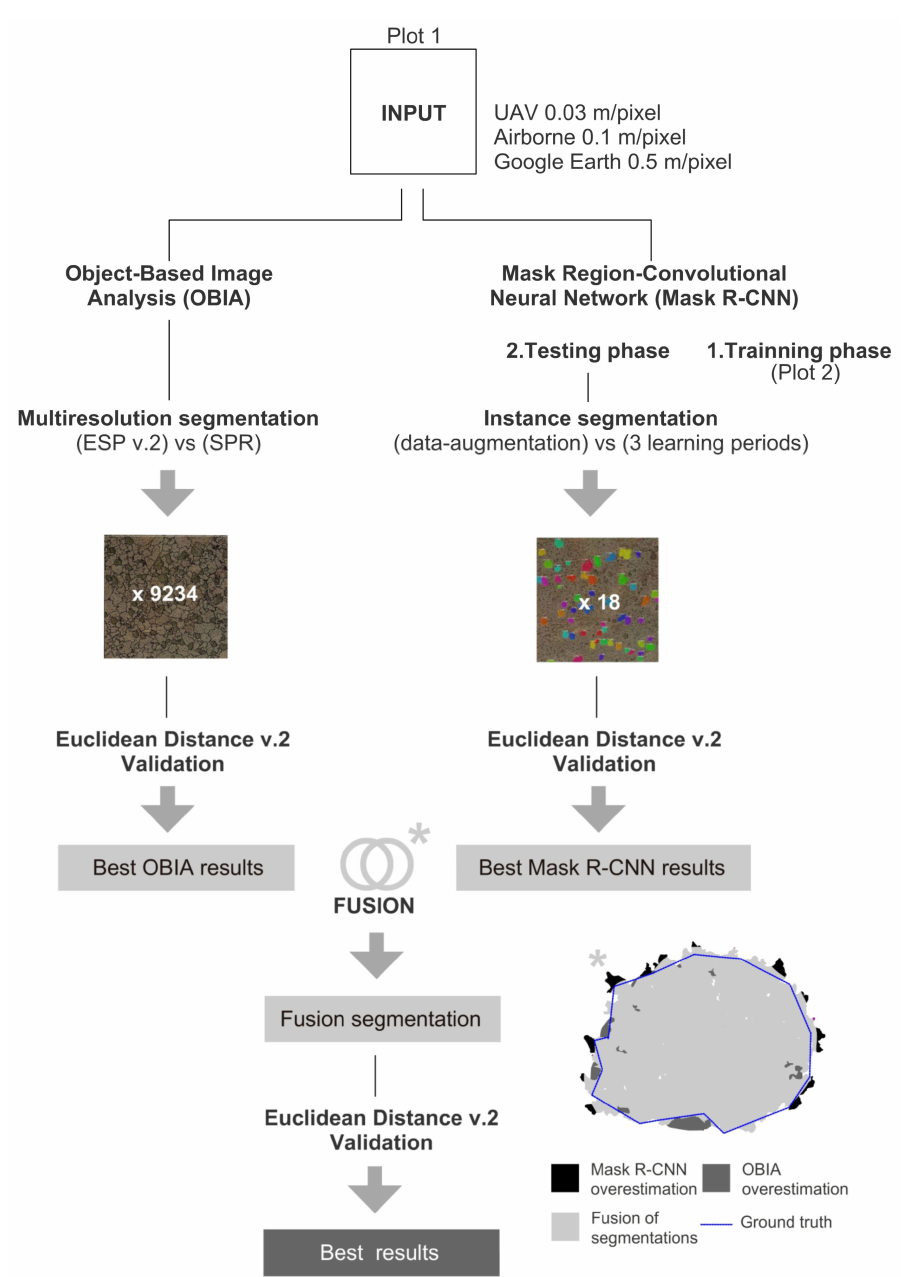
Figure 1. Workflow with the main processes carried out in this work. Asterisk shows an example of the result of the fusion of the segmentation results from OBIA and Mask R-CNN. OBIA: Object- Based Image Analysis; Mask R-CNN: Mask Region-based Convolutional Neural Networks; ESP v.2: Estimation of Scale Parameter v.2; SPR: Segmentation Parameters